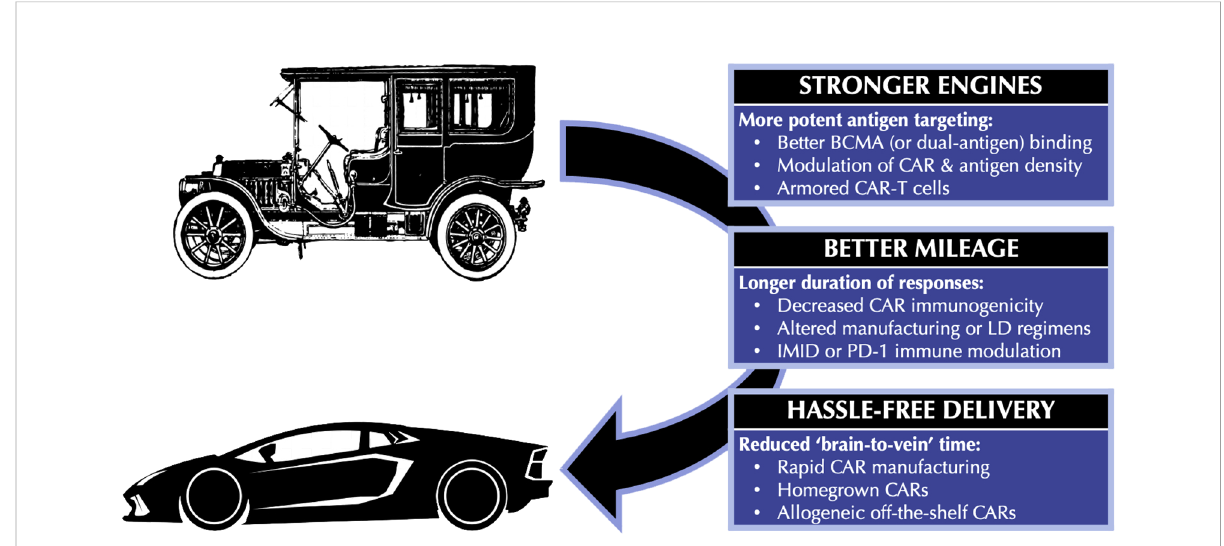
FIGURE 1 Automotive analogies for improving BCMA CAR-T therapy. BCMA, B-cell maturation antigen; CAR, chimeric antigen receptor; CAR-T, chimeric antigen receptor T-cell; IMID, immunomodulatory drug; LD, lymphodepletion; PD-1, Programmed Death